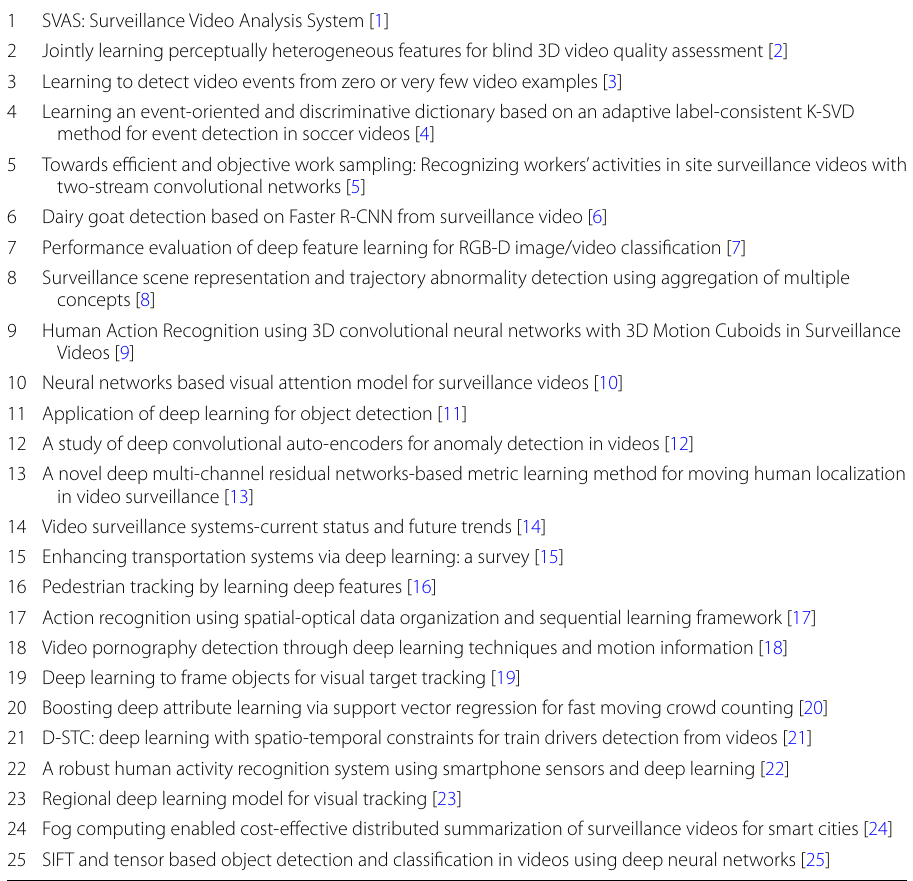
Table 1 Title of 25 papers published in